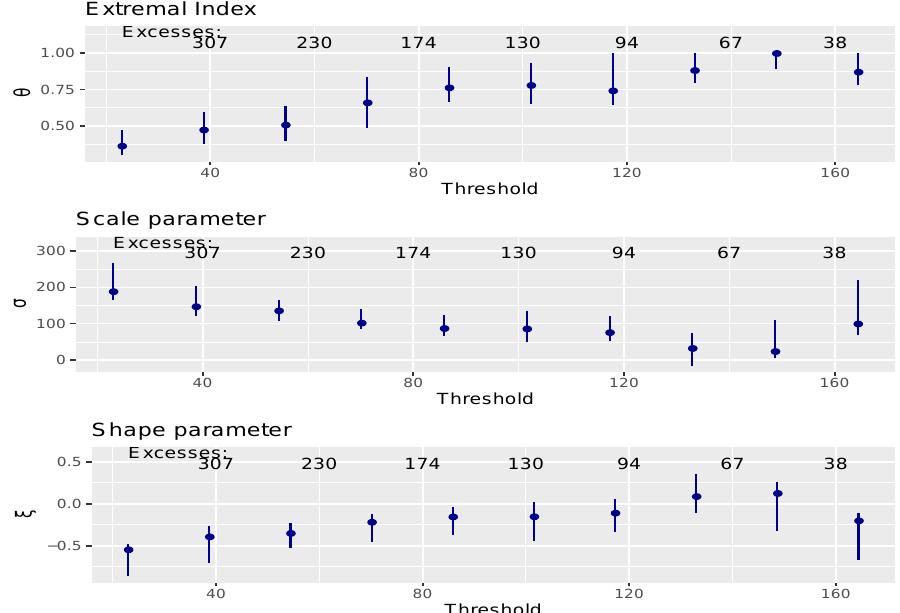
Figure 5. Threshold stability plots. Top panel: Stability plot for the extremal index. Middle panel: Stability plot of the scale parameter. Bottom panel: Stability plot of the shape